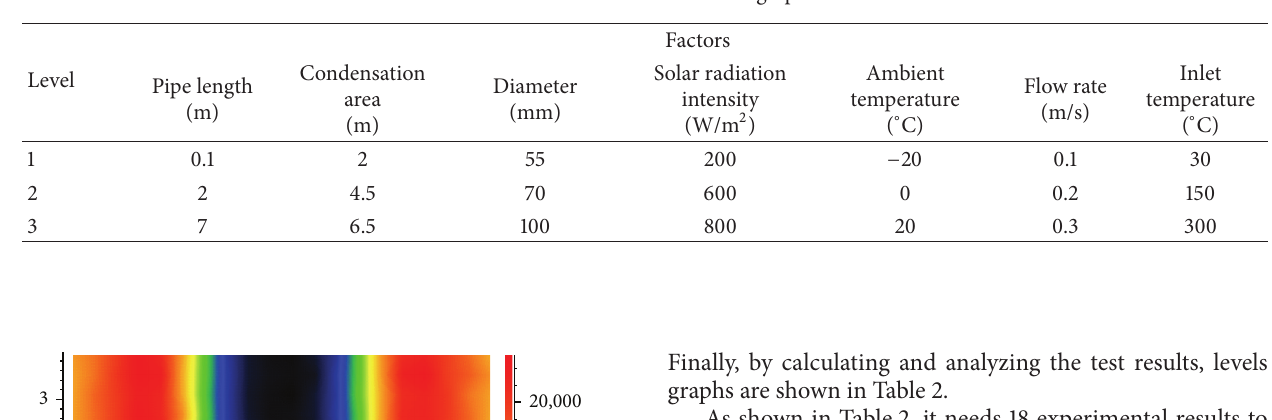
Table 2: The factors and levels graph.